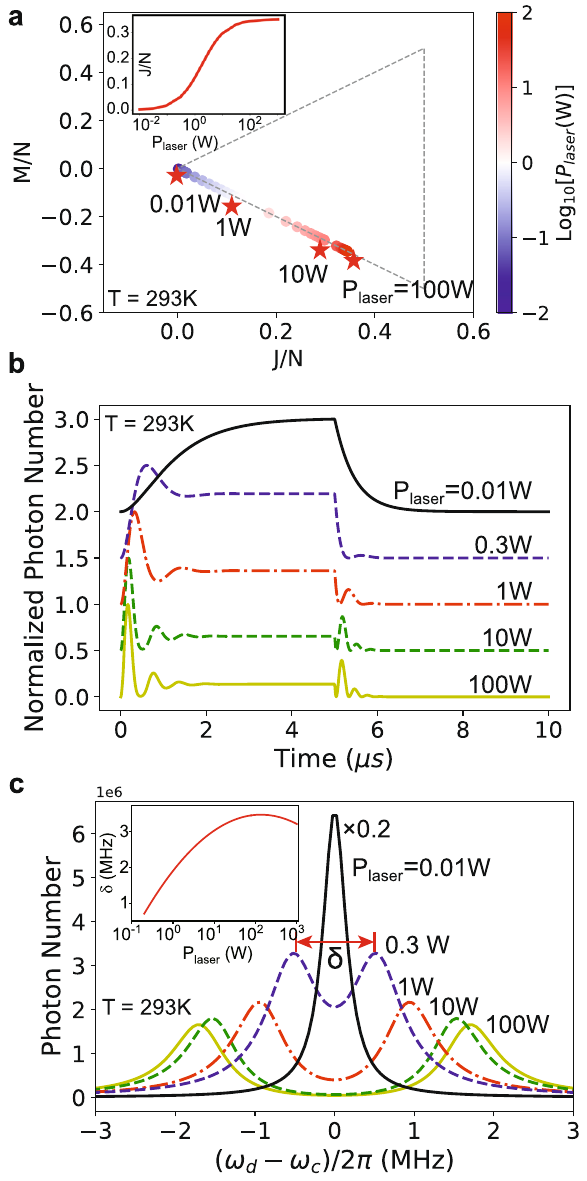
Fig. 4 Room-temperature C-QED effects with NV center spins coupled to a 532 nm laser fi eld and a microwave resonator fi eld mode. a Representation of the + 1, 0 spin level steady-state populations and spin-spin correlations by the average of the Dicke state quantum numbers J , M (normalized by the total number N of NV centers) for different values of the laser power. The gray dashed lines indicate the boundary of the Dicke state space. The inset shows J / N as a function of laser power. b , c Dynamics of the normalized intra-resonator photon number for the system driven resonantly by a pulsed microwave fi eld of duration 5 μ s and strength Ω = 2 π × 9.7 × 10 5 Hz − 1/2 ( b ), and the steady-state intra-resonator photon number for the system driven by a continuous-wave microwave fi eld as a function of the detuning of the microwave driving fi eld frequency ω d and the microwave resonator frequency ω c ( c ), where the diamond is illustrated by a 532 nm laser with increasing power 0.01, 0.3, 1, 10, 100 W. In b , the curves are shifted vertically for the sake of clarity. The inset of c shows the Rabi splitting δ as a function of the laser power. Here, we have considered the system with ten times more NV centers than that used in the experiment 16